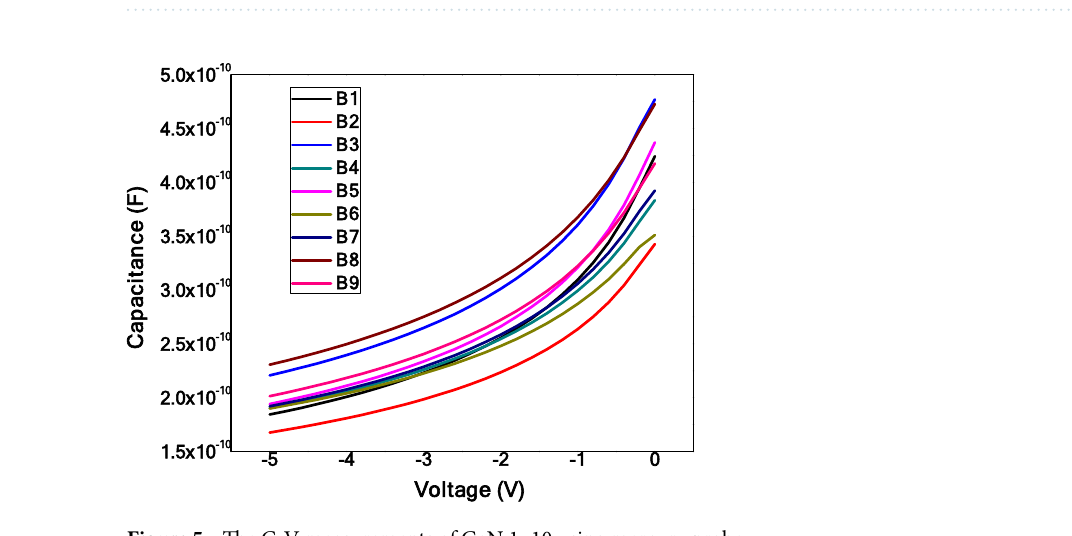
Figure 4. The UV–Vis spectra of GaN-B1 before irradiation, after irradiation, and after annealing.